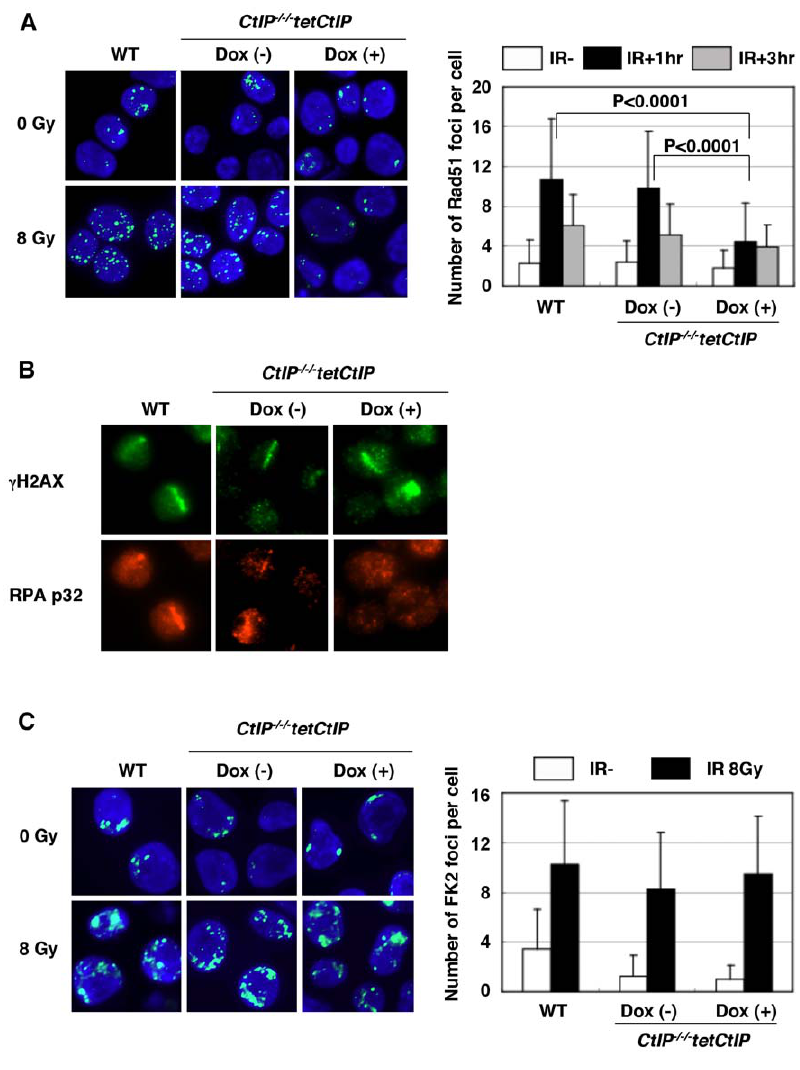
Figure 2. Impaired c -ray–induced Rad51 focus formation in CtIP -depleted cells. (A) CtIP 2 / 2 / 2 tetCtIP cells, with or without 24 h doxycycline treatment, were exposed to 8 Gy ionizing radiation (IR). One hour after irradiation, cells were stained with anti-Rad51 antibody. The graph shows the quantification of Rad51 foci per cell. More than 100 cells were analyzed. (B) Accumulation of RPA protein in the cells exposed to 405 nm pulse laser. Cells were fixed with 4% PFA 1 h post laser stimulation and stained with anti- c H2AX and anti-RPA p32 antibodies. (C) Conjugated-ubiquitin (FK2) focus formation in wild-type (WT) or CtIP 2 / 2 / 2 tetCtIP DT40 cells (with or without doxycycline) at 1 h post IR (8Gy). Quantification of FK2 foci per cell is shown in the graph. More than 100 cells were